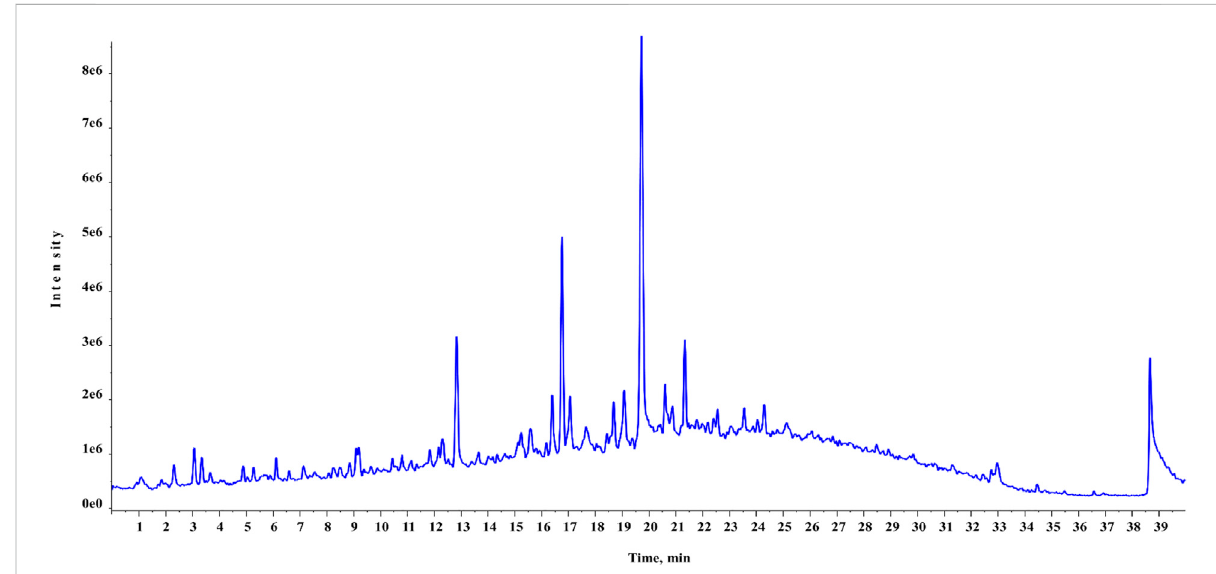
FIGURE 3 Total ionic chromatogram (TIC) of HAECA (negative mode in UPLC-Q-TOF-MS analysis).